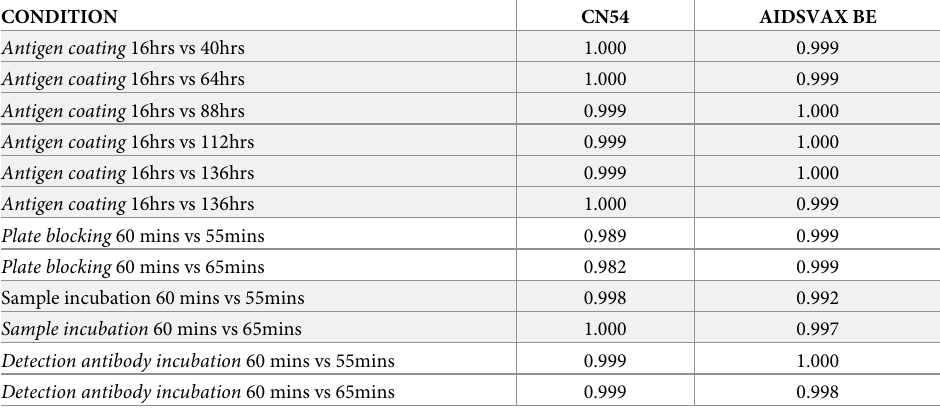
Table 4. Statistical comparison of robustness phase 2 parameters. Data shown are Dunnett’s test p values.